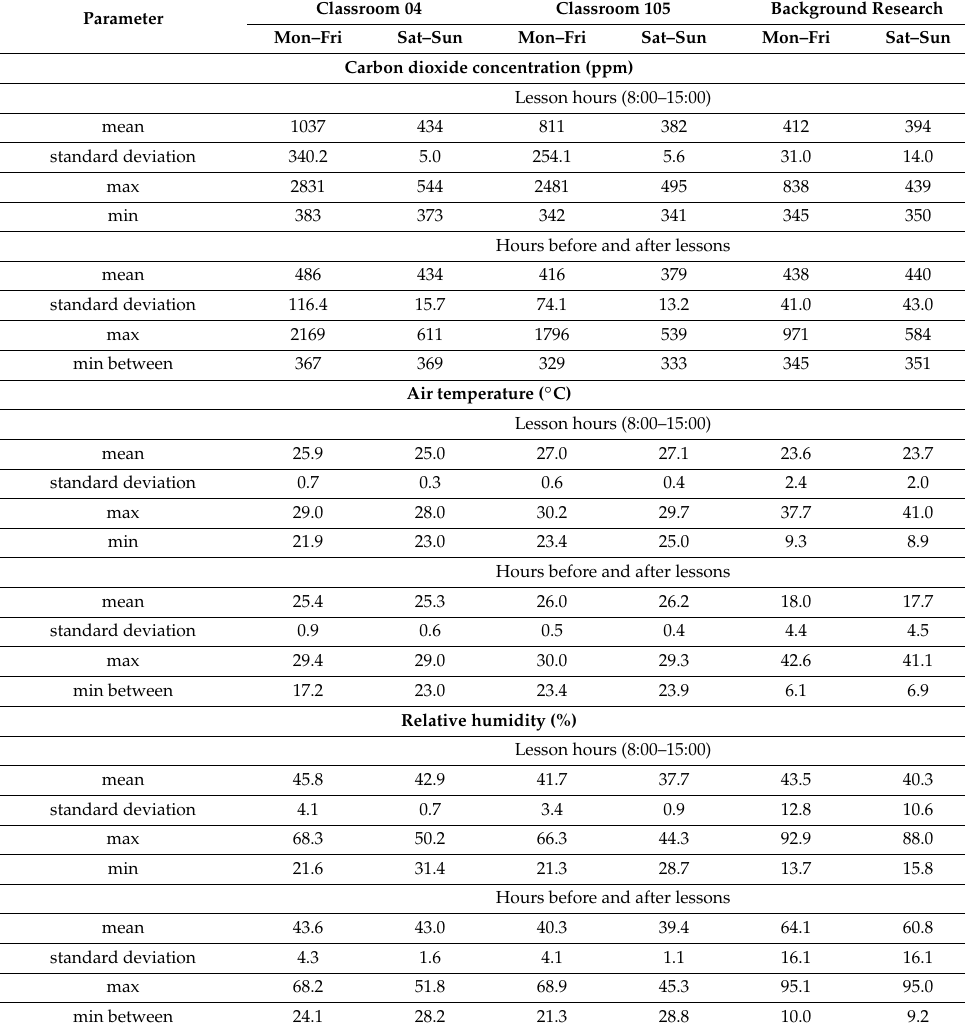
Table 2. Statistical analysis of air quality measurements—CO 2 (ppm), temperature ( ◦ C), and RH